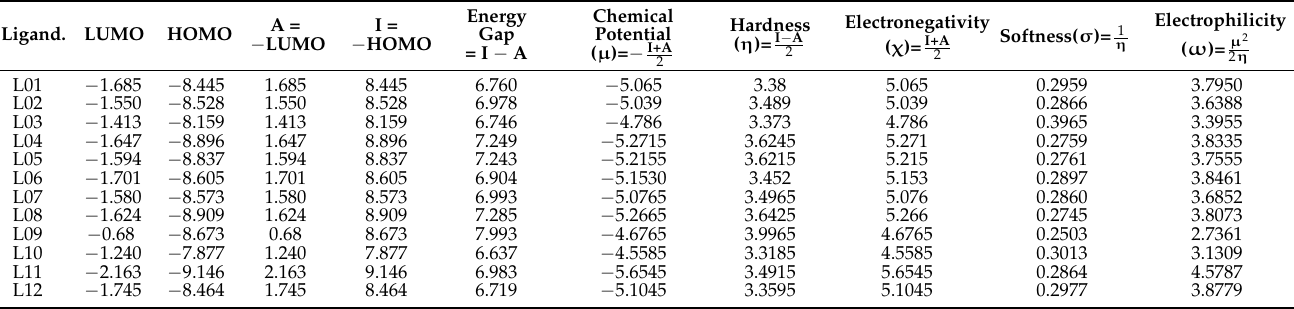
Table 3. Data of chemical